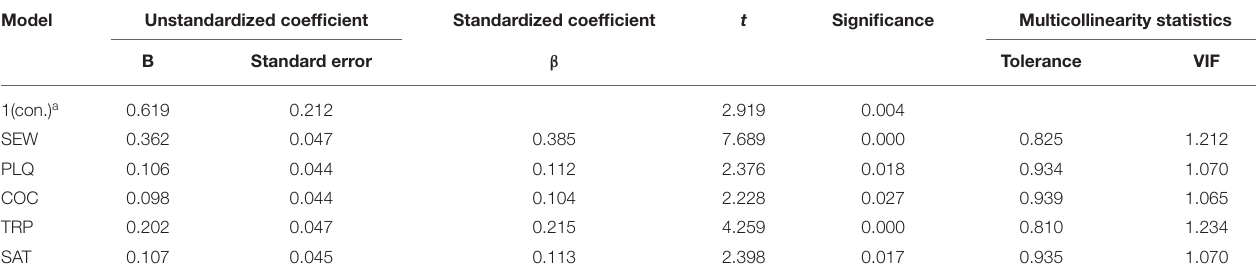
TABLE 4 | Results of multicollinearity analysis.